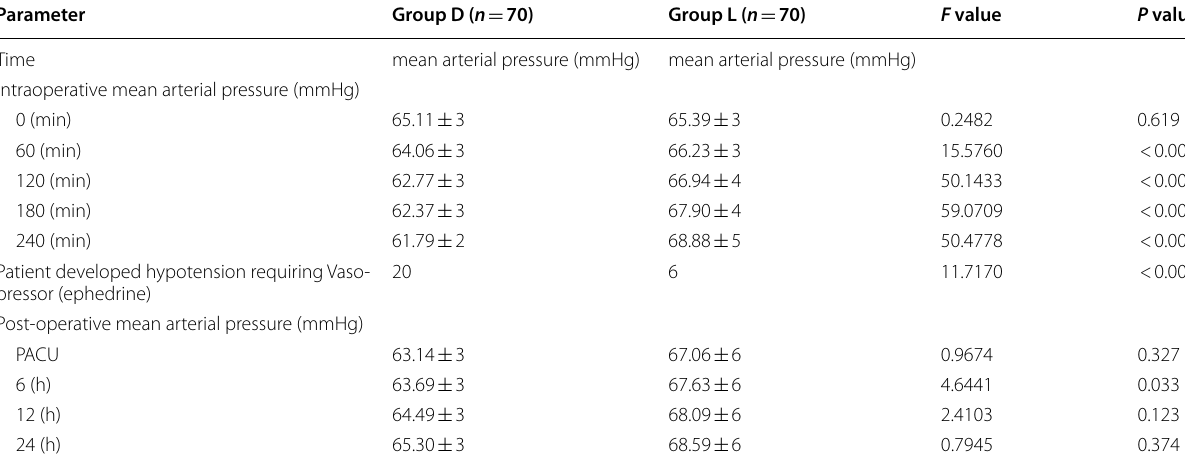
p value < 0.05 is considered significant